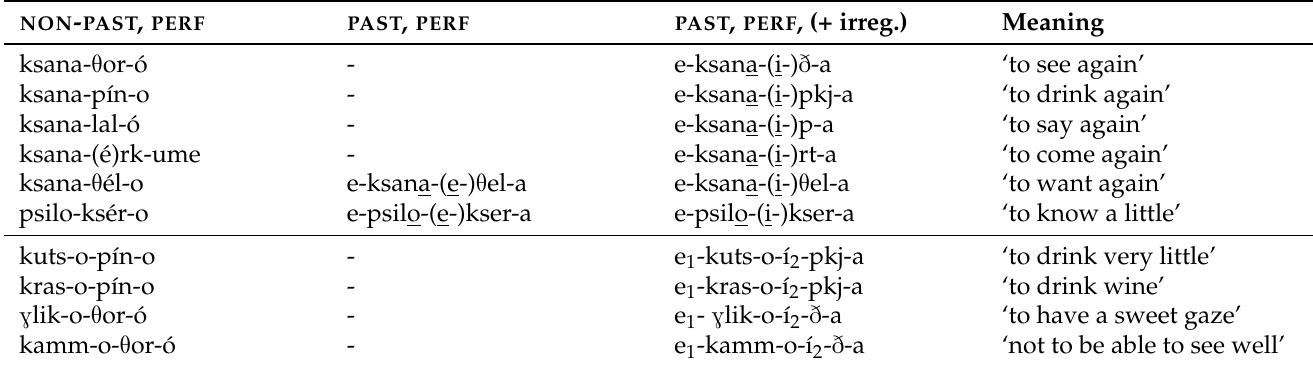
Table 7. Verbal complexes with irregular i-